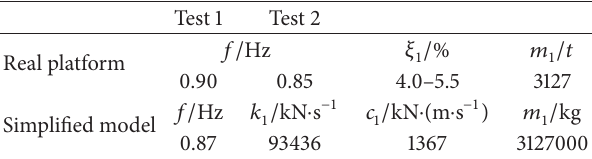
Table 1: Parameters of the offshore jacket